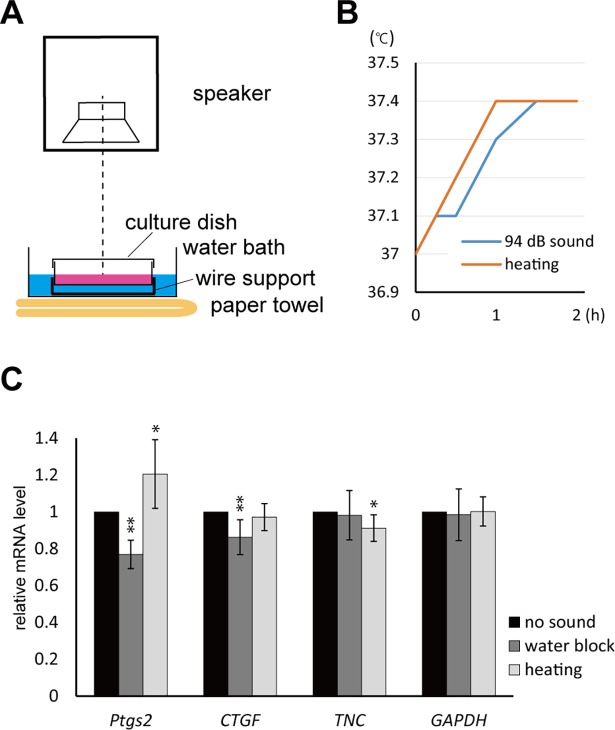
Water block and heating assays.(A) Water block assay was performed by floating a culture dish on a water bath in the incubator. Wire support was used to avoid movement of the dish during the assay. (B) Emission of 440 Hz, 94.0 dB, sine-wave sound resulted in the 0.4°C increase in the temperature of the culture medium in a dish (blue line). The effect of the heat itself was tested by changing temperature setting of the incubator to mimic similar heating condition (orange line). (C) Summary of the RT-qPCR result of water block (with 440 Hz, 94.0 dB, sine-wave sound) and heating (without sound) conditions. Total RNA was extracted 0 and 2 hours. (Error bars represent standard deviation, n > 5. * indicates P < 0.05 and ** indicates P < 0.01 to the 0 hour sample.).